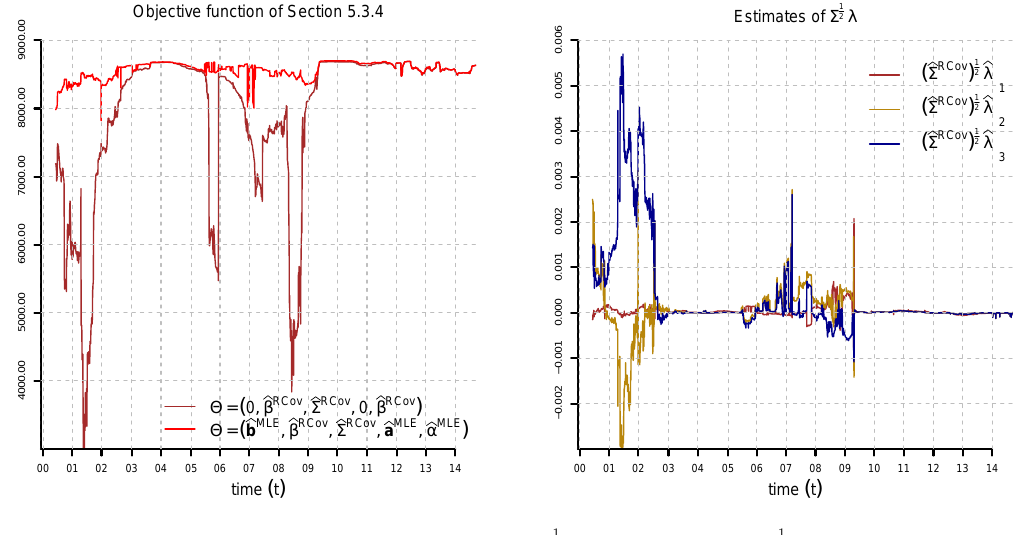
Figure 14. Objective function log L t (lhs) and ( Σ 1 2 λ ) 1 = b 1 − a 1 , ( Σ 1 2 λ ) 2 = b 2 − a 2 and ( Σ 1 2 λ ) = b − a 3 3 3 (rhs) given by optimization (24) in the three-factor model for K τ 1 = 1, τ 2 = 2, τ 3 = 5, τ 4 = 10, τ 5 = 21, τ 6 = 63, w ij = 1 { i = j } and S = 10 − 5 · 1 . We compare the value of the objective function for ( b , β , Σ , a , α ) = ( 0 , β RCov , Σ RCov , 0 , α RCov ) and the numerical solution of the optimization. The configuration ( 0 , β RCov , Σ RCov , 0 , α RCov ) is almost optimal in low interest rate